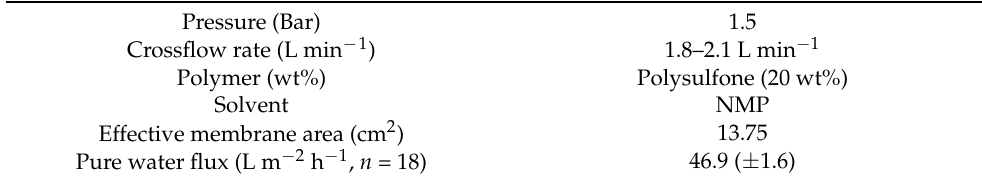
Table 1. Brief summary of the experimental conditions of the membrane fabrication and filtration and the pure water flux of the UF